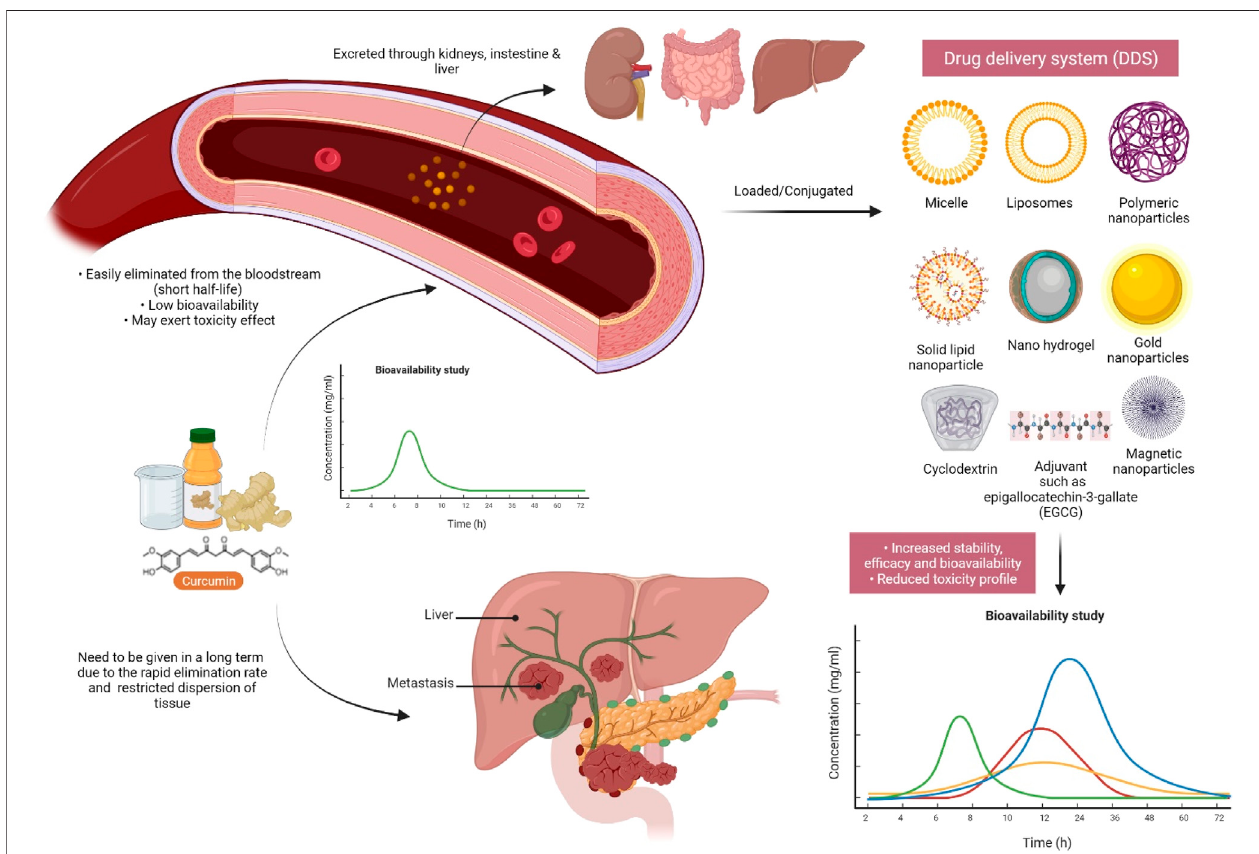
FIGURE 8 | Curcumin must be modi fi ed/improved prior to future research due to its extremely low bioavailability. Due to the quick elimination of curcumin in the systemiccirculationas aresult ofenzyme metabolism, conjugating curcuminto adjuvantsor other deliverysystems may be bene fi cial in order toincreaseits half-life and